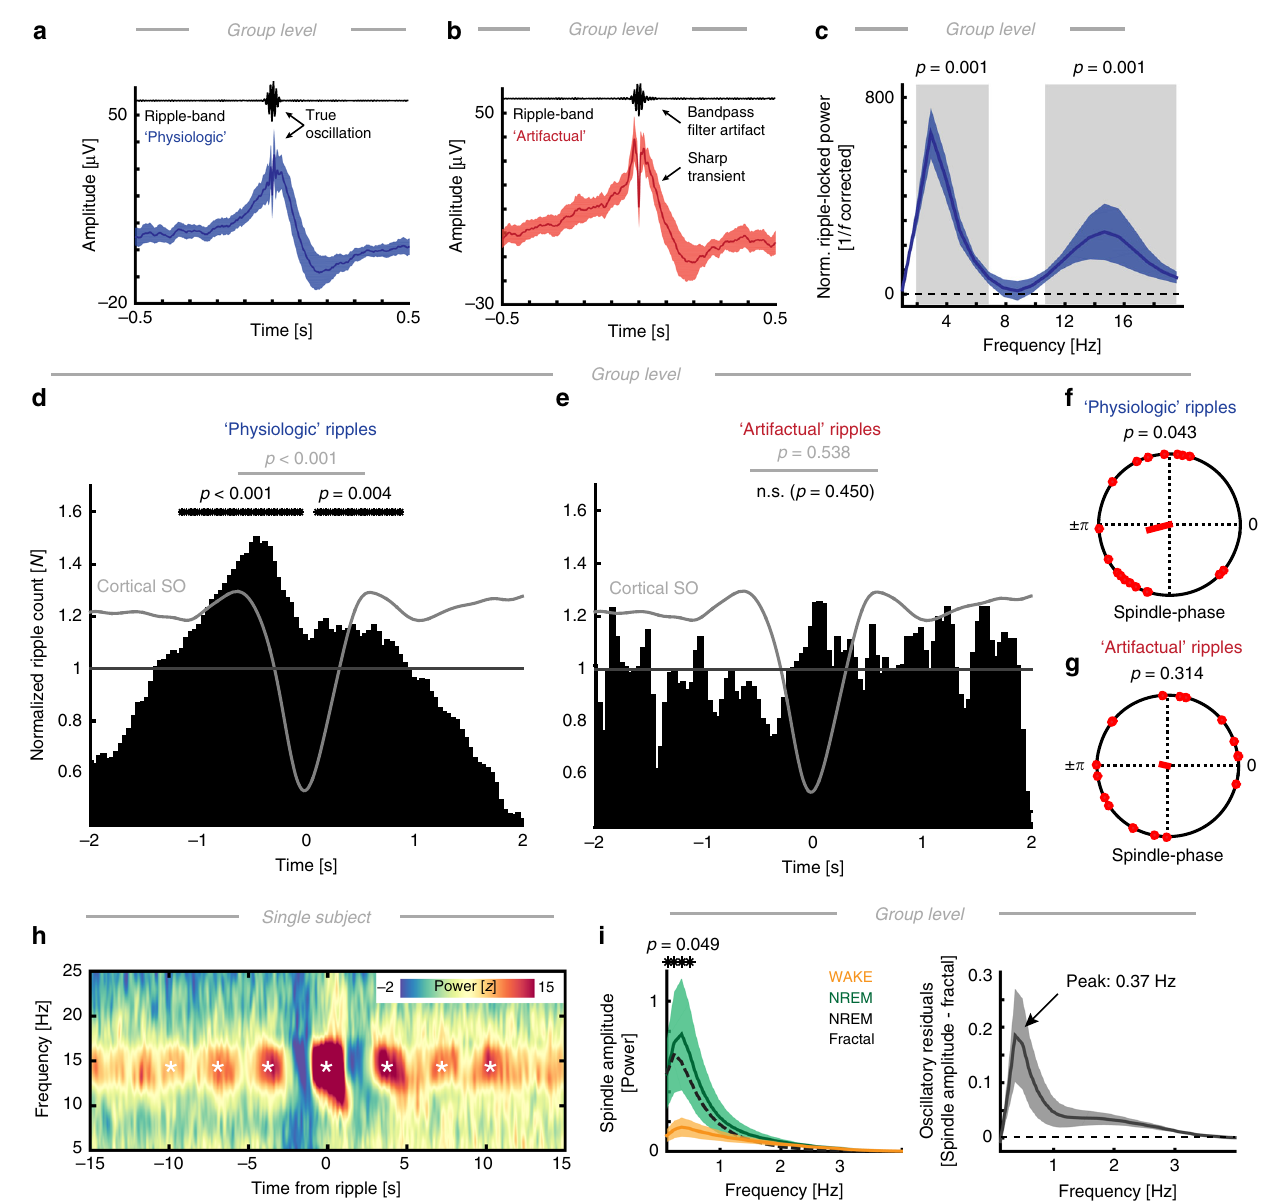
Fig. 4 Physiological and artifactual ripple activity in the MTL. a Ripple-locked grand average (blue; N = 18) and the band-bass fi ltered signal (black; mean ± SEM). b Artifactual ripple events grand average (red) that are characterized by sharp transients that are arti fi cially rendered sinusoidal by band-pass fi ltering (black). c 1/f-corrected power spectrum (mean ± SEM; irregular resampling) in the MTL during a ripple event exhibits two distinct oscillatory peaks: in the delta and spindle frequency range. Gray shaded areas indicate signi fi cant oscillatory activity (cluster test: p = 0.001). d Histogram of ripple occurrence relative to the cortical SO as detected at scalp level. Note ripple occurrence is enhanced during the cortical upstate (i.e., the SO peak, fi rst cluster: p = 0.0010, d = 2.82; second cluster: p = 0.0040, d = 1.42), but signi fi cant more ripples occur prior to the downstate (in gray; 400 ms window around the SO peaks, paired t -test: t 17 = 5.01, p < 0.0001, d = 1.88). e This relationship was not present for artifactual ripple events, which occurred at random (smallest cluster p = 0.450; no peak differences: t 17 = − 0.63, p = 0.5381, d = 0.27). f Physiologic ripples were preferentially nested in the trough of the cortical spindle oscillation (V-test against ± pi: v = 5.13, p = 0.0434, mvl = 0.29). g This tight temporal relationship was again not present for artifactual ripple events ( v = 1.46, p = 0.3135, mvl = 0.08). h Single subject ripple-locked EEG spectrogram indicates the presence of cortical spindle oscillations during a hippocampal ripple. Note that activity in the spindle range can be observed before and after the ripple (every ~3 s; asterisks indicate elevate spindle power). i Left Spectral analysis of the spindle amplitude (green), its fractal (1/f estimate; black dashed line) as obtained from irregular resampling as well as the wake condition as a control (absence of spindle activity; cluster test: p = 0.0490, d = 0.49). Right: after subtraction of the fractal component from the NREM spectrum, we observed a distinct oscillatory peak indicating a rhythmic comodulation at ~0.37 ± 0.03 Hz (median ± SEM; sign test against zero: p < 0.0001; d = 0.70). All error bars indicate the mean ±